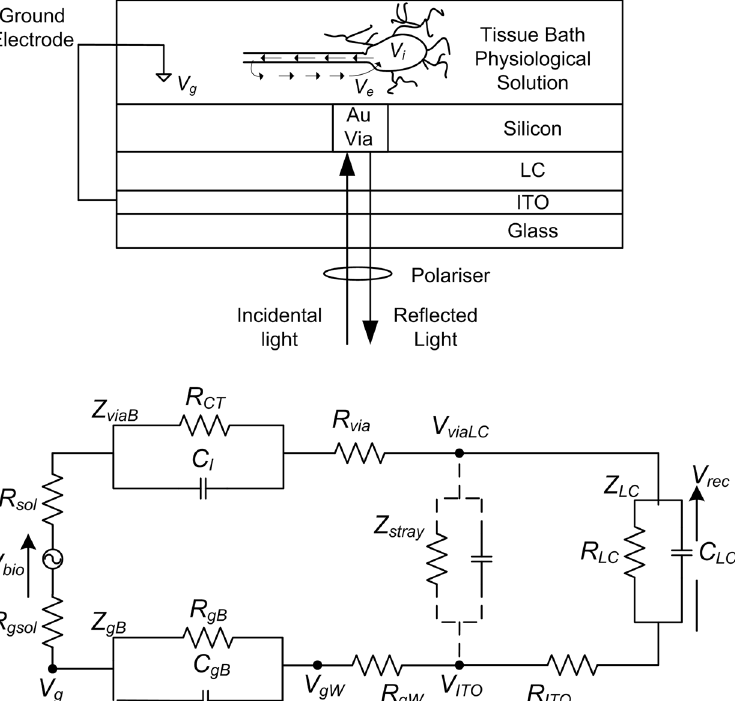
Figure 2. Circuit model of extracellular recording by the optical biopotential electrode (optrode). V bio : extracellular biopotential, V rec : transduced signal. R sol ( R gsol ): spreading or solution resistance of bathing physiological solution seen from optrode (ground). R via : resistance of each of the optrode vias. R gW : resistance of the cable connecting the ITO and ground reference electrode. Z gB , R gB , C gB : impedance, resistance, and capacitance of the bilayer between ground electrode and bathing solution. R gW : resistance of cable connecting the ITO and ground electrode. Z viaB , R CT , C I : impedance, resistance and capacitance of the via-bathing solution bilayer. Z stray : stray impedance, Z LC , R LC , C LC : impedance, resistance, and capacitance of the LC layer. R ITO : resistance of the ITO